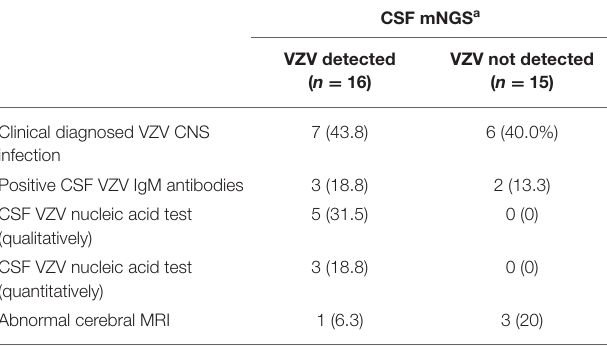
TABLE 2 | Diagnosis of VZV CNS infection.